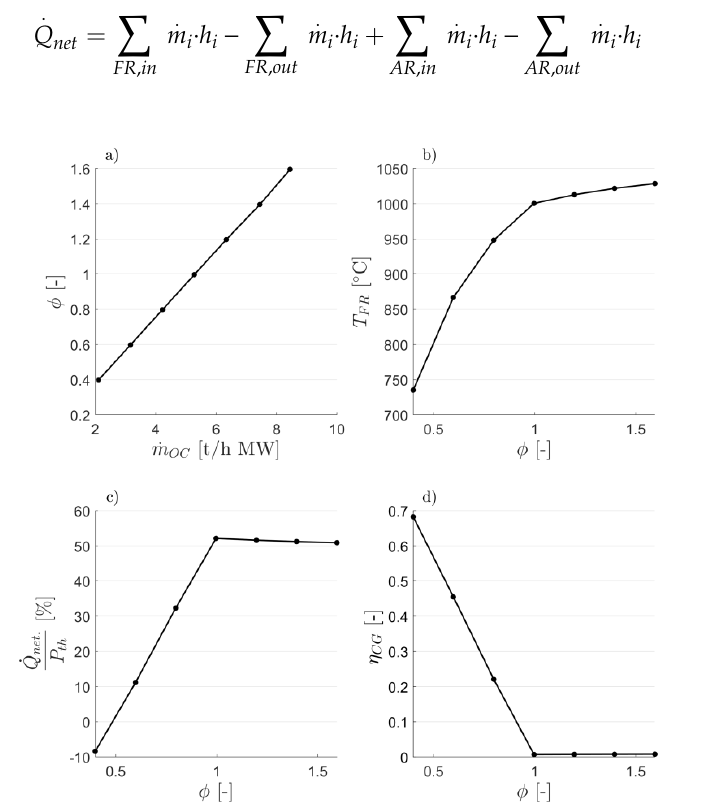
Figure 5. Simulation results for CLG operation through reduced OC circulation. OC-to-fuel ratio as a function of the OC circulation rate ( a ). Fuel reactor temperature ( b ), relative net process heat ( c ), and cold gas efficiency ( d ) for different values of 𝜙 ( 𝜆 = 1.2).